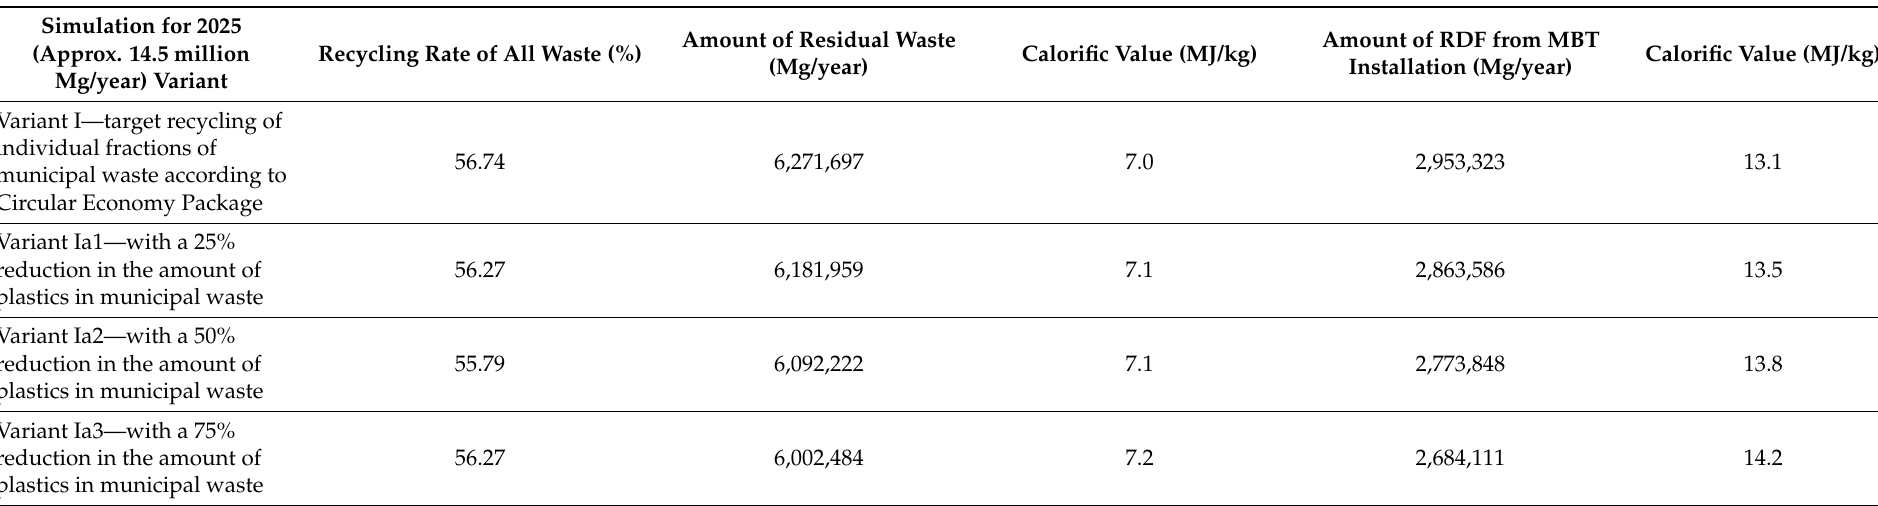
Table 12. The amount and calorific value of residual waste and the caloric fraction for various variants of the implementation of the Circular Economy Package—the effect of glass reduction in municipal